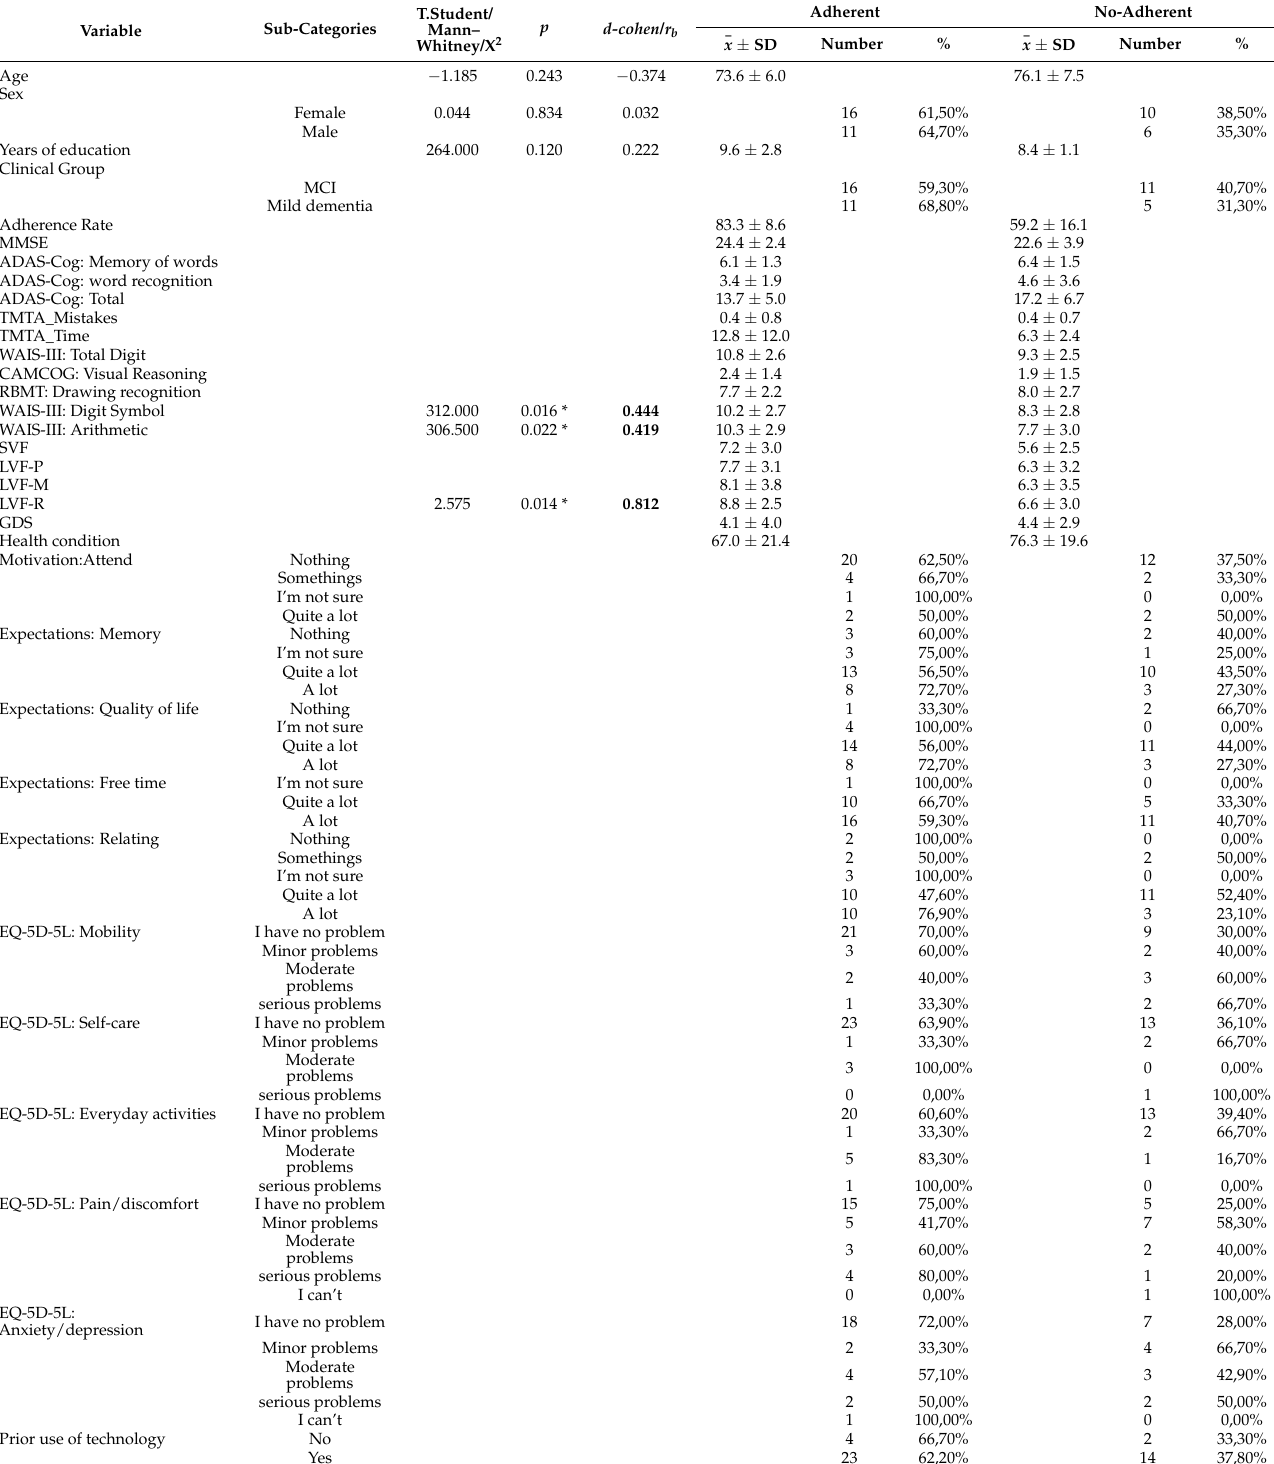
Table 2. Baseline characteristics for the adherent and non-adherent